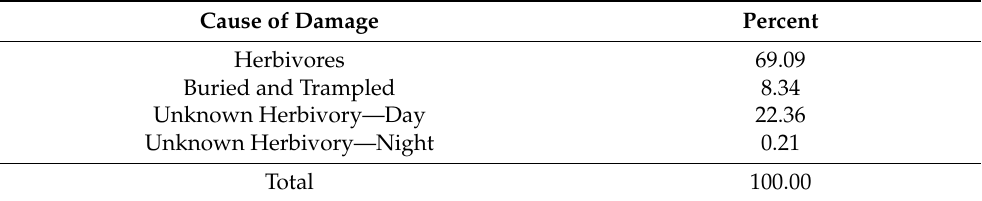
Table 4. Percent damage caused to seedlings separated by category. Herbivores damaged the largest proportion of seedlings